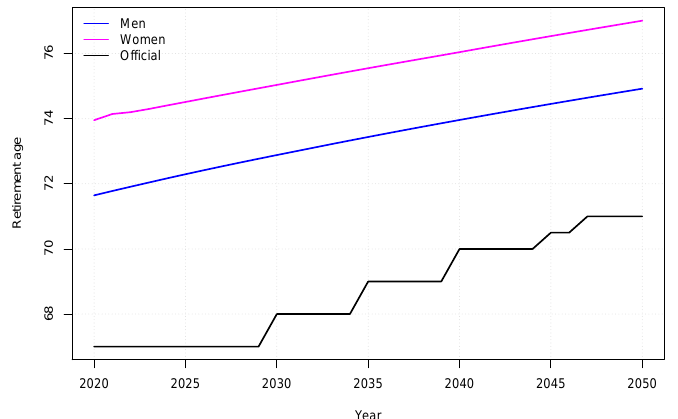
Figure 7. DNK: Forecast of the legislated retirement age and age with remaining cohort life expectancy equal to the 14.5 years